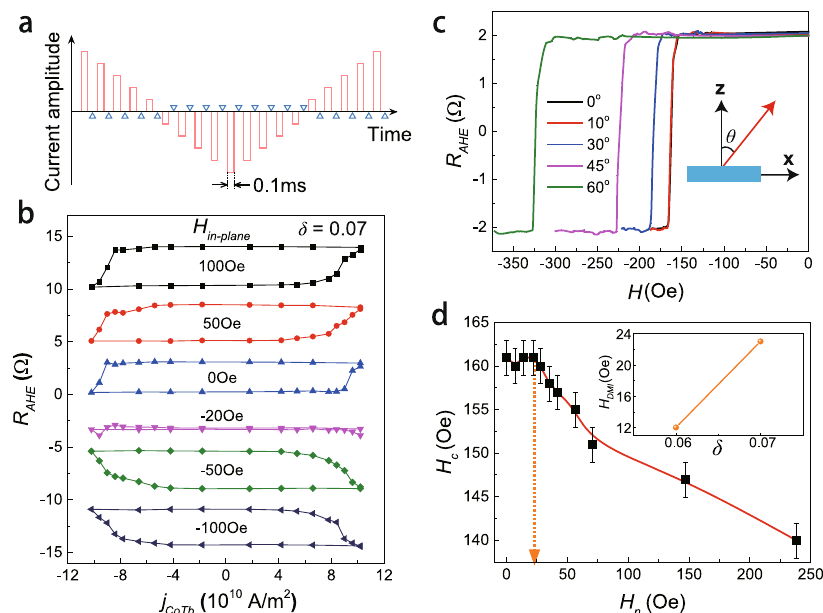
Fig. 3 SOT switching experiments and DMI measurement. a Measurement scheme of SOT switching. Writing pulses with a width of 0.1 ms were applied from positive to negative, and then back to positive. After each writing pulse, a small read current was applied to detect the magnetic state of the CoTb layer by AHE. b SOT switching curves of the sample with δ = 0.07 under different in-plane magnetic fi elds (including zero- fi eld). c AHE curves when the magnetization switches from up to down under different magnetic fi eld angles θ with respect to the fi lm normal direction. The inset shows the de fi nition of θ in the xz plane. d H c as a function of H n . There is a threshold value of H n ( (cid:3) 23 Oe), above which H c starts to decrease. Error bars are obtained from repeated measurements for each θ . The inset shows the increasing relationship between H DMI and δ in 6 nm CoTb fi